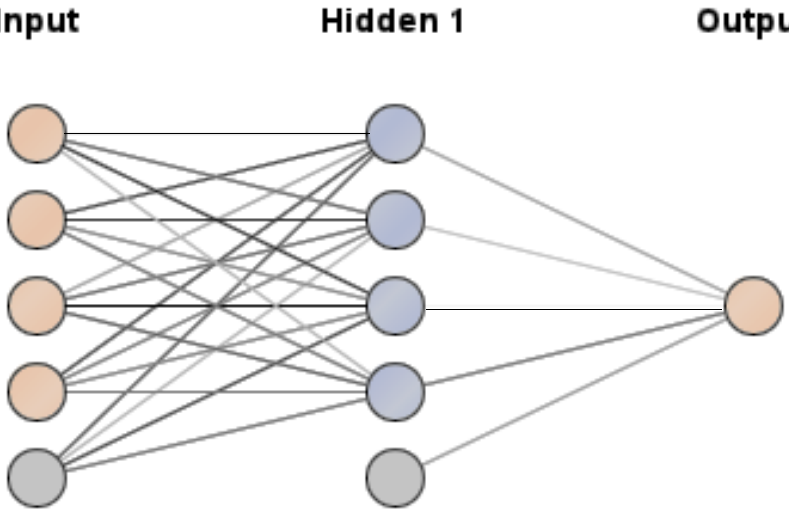
Figure A2. ANN MLP graph model.